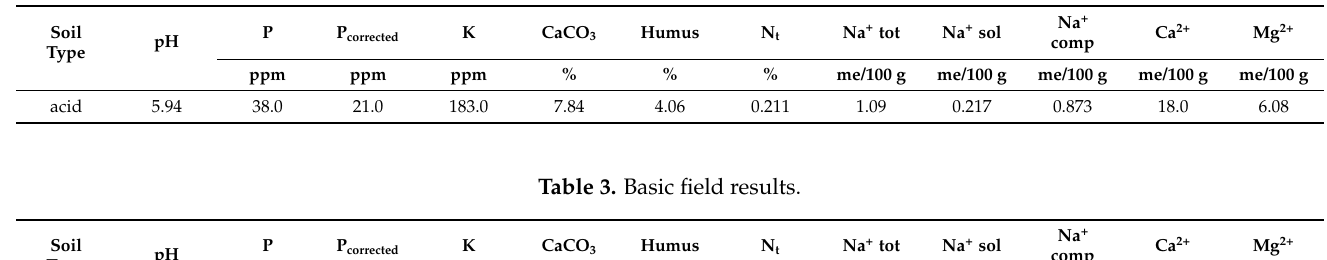
Table 2. Acidic field results.